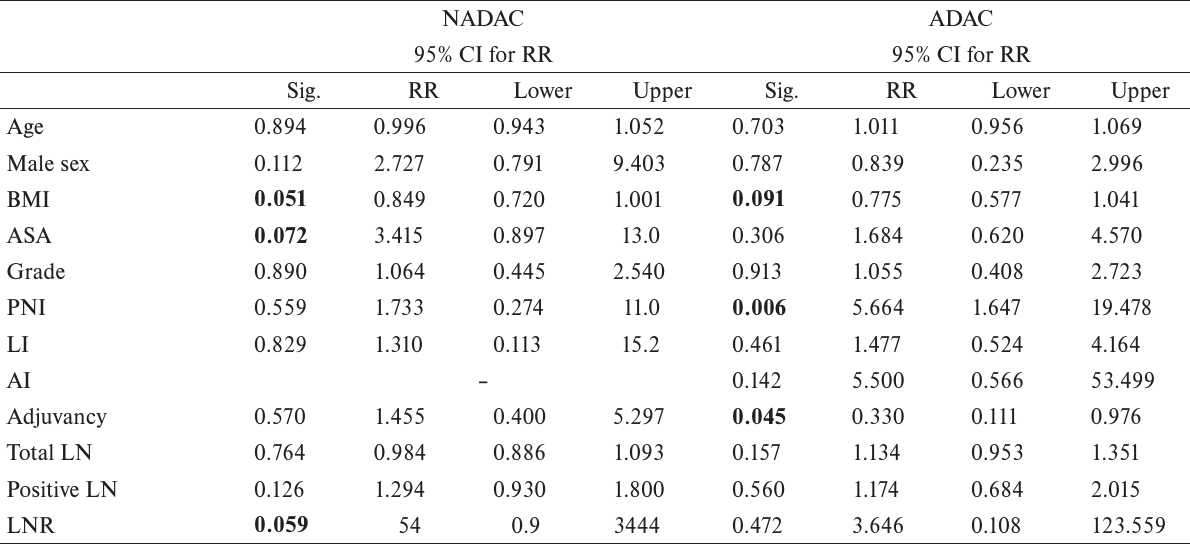
Table 2. Overall survival (OS) and parameters in NADAC and